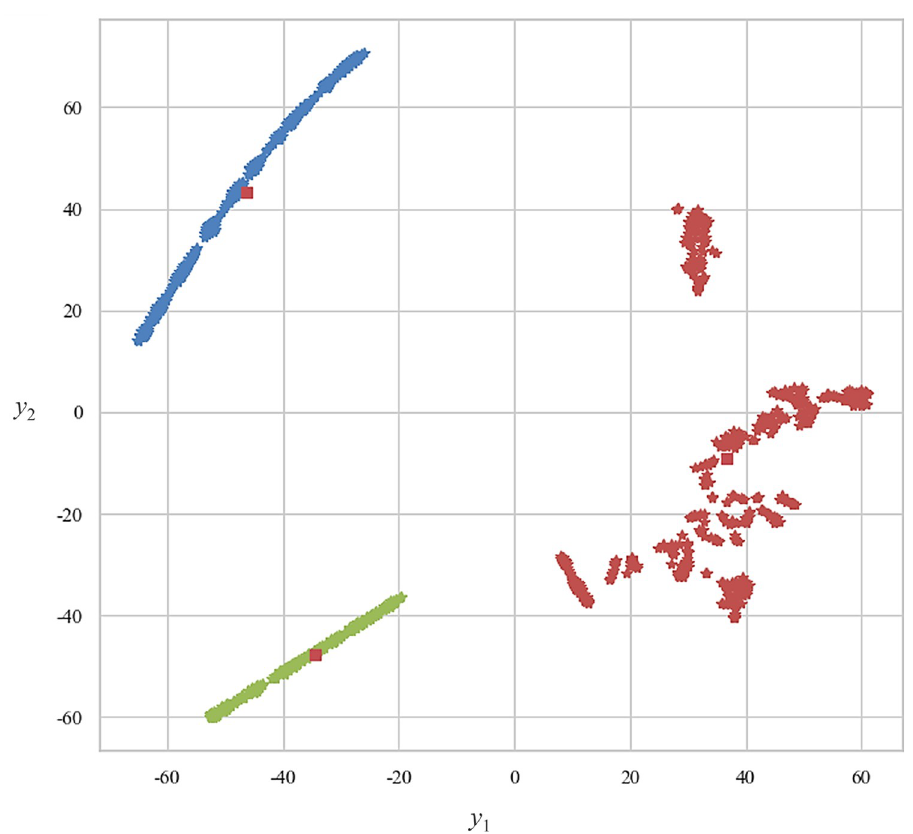
Fig 4. Embedding of clustered PSSFC into two dimensions via t -SNE.